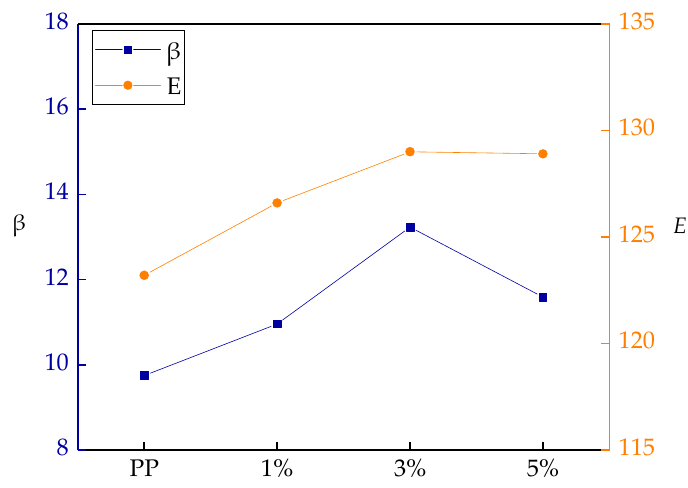
Figure 5. Weibull parameters of AC breakdown strength of various samples.